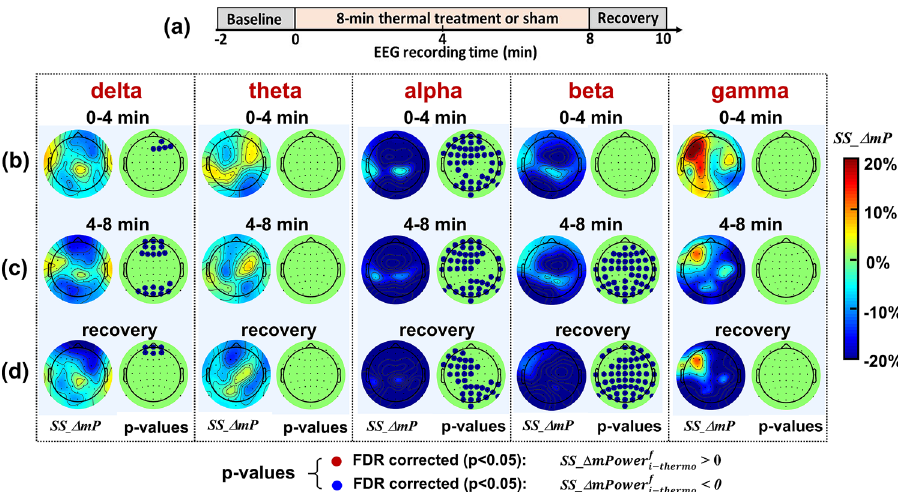
Figure 4. ( a ) Outlines the protocol timing: 2-min baseline, 0–4 min and 4–8 min temporal periods for thermo_ stim/sham, and 8–10 min recovery. ( b )–( d ) show topographies of group-averaged (n = 11) SS_ΔmP and p-value maps with FDR correction based on paired permutation tests between SS_ΔmP values under thermo_stim vs sham conditions during 0–4 min thermo_stim/sham, 4–8 min thermo_stim/sham, and 8–10 min recovery, respectively, at five frequency bands. In the p -value maps, the blue dots with SS _ � mPower electrodes where thermo_stim induced significant reduction in ΔmPower (FDR corrected p < 0.05) compared to the sham condition. No red dots are shown in any of the topographies at three temporal segments and 5 frequency